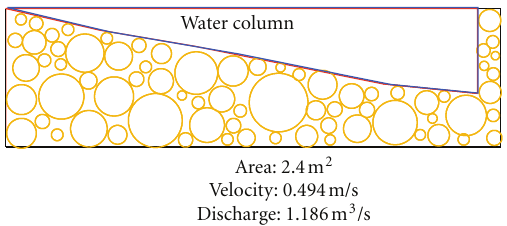
Figure 12: Average flow from studied lakes into River Ayer Hitam.